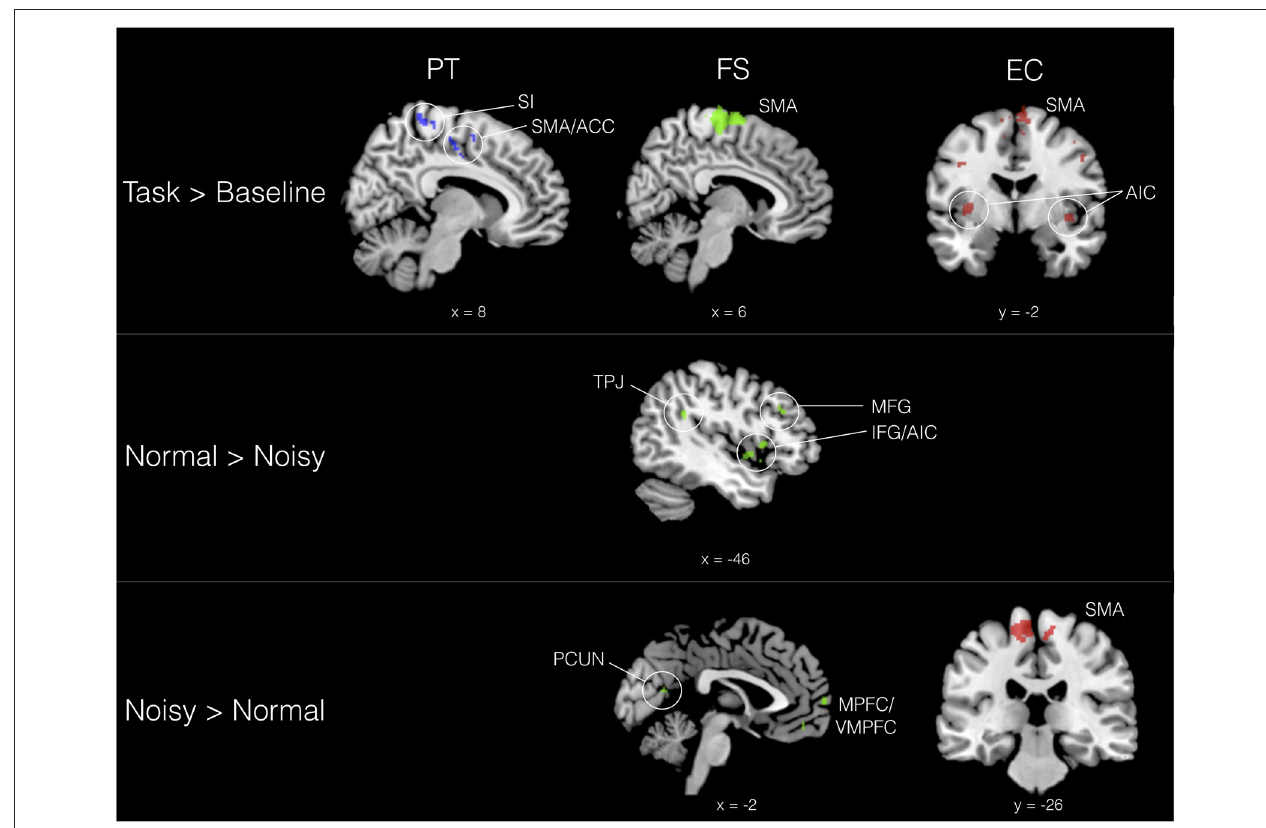
FIGURE 2 | Selected activation sites correlating with trait empathy (IRI subscales) in three contrasts. Perspective taking ( PT ) = blue, fantasy (FS) = green, empathic concern (EC) = red. All contrasts, Z > 2.3, p < 0.01 (cluster corrected, p <